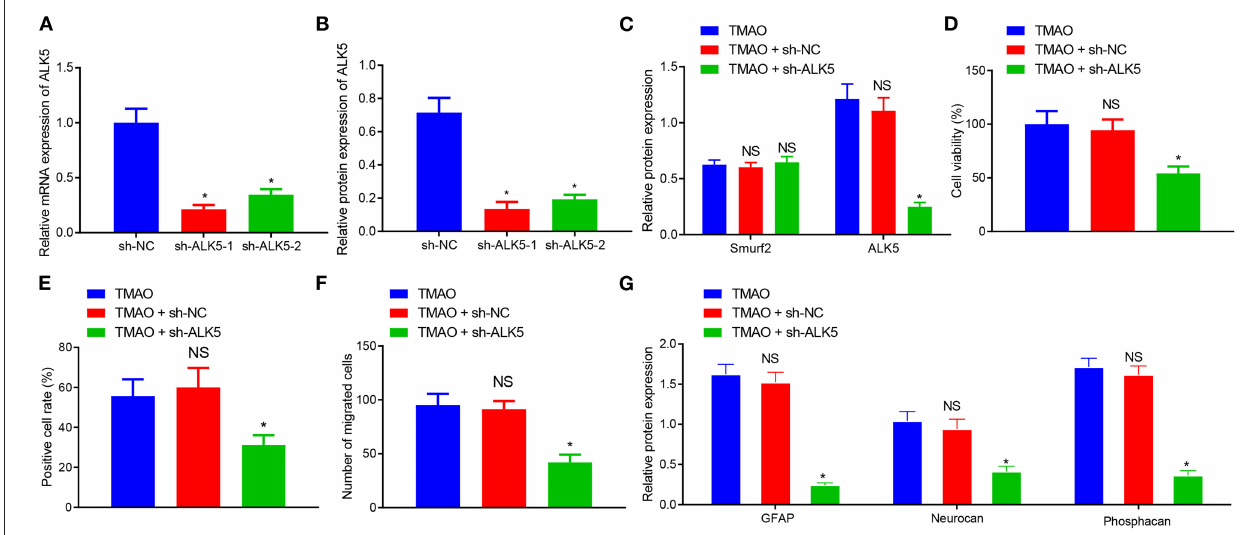
FIGURE 5 | Silencing of ALK5 attenuates the promoting effect of TMAO on astrocyte proliferation, migration and viability. (A) Transfection efficiency of ALK5 in cells examined using RT-qPCR. (B) Protein expression of ALK5 in cells analyzed using Western blotting. (C) Expression of ALK5 and Smurf2 in cells determined by Western blotting. (D) Cell viability evaluated using CCK-8 assay. (E) Cell proliferation evaluated using EdU assay. (F) , Cell migration evaluated using Transwell assay. (G) , The expression of GFAP, Neurocan and Phosphacan in each group of cells detected by Western blotting. * p < 0.05 compared with the sh-NC group or the TMAO + oe-NC group. NS, p > 0.05 compared with the TMAO group. Unpaired t -test is adopted for data comparison between two groups. One-way ANOVA is employed for data comparison among multiple groups followed by Tukey’s post hoc test.